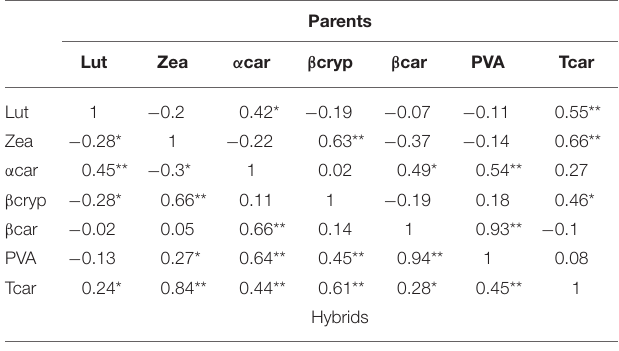
TABLE 6 | Pearson’s correlation coefficients between mean values of carotenoid concentrations in the parent (upper-half matrix) and F1 hybrid (lower-half matrix) maize trials.